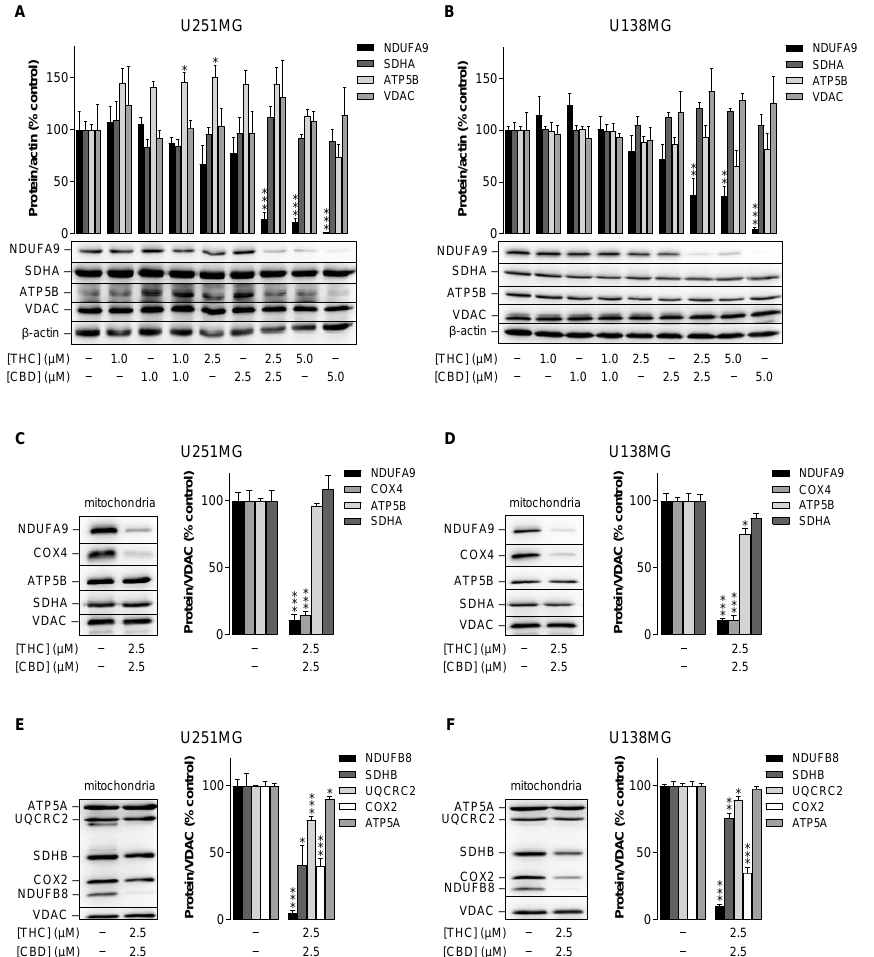
Figure 4. Influence of THC and CBD, administered alone or in combination, on protein levels of subunits of ETC complexes I (NDUFA9, NDUFB8), II (SDHA, SDHB), III (UQCRC2), IV (COX2, COX4) and V (ATP5A) in human glioblastoma cells. U251MG and U138MG cells were incubated with selected concentrations of THC and CBD or their combination (in a ratio of 1:1) for 24 h. Subsequently, cellular total protein extracts ( A , B ) or isolated mitochondrial fractions ( C – F ) were analysed for specific subunits of different ETC complexes by Western blots. All percentage values shown refer to the vehicle control, which was set to 100%. The values shown in the bar graphs are based on densitometric analyses of blots, whereby the specific subunits were normalised to β -actin ( A , B ) or VDAC ( C – F ). The blots shown are representative. The data in all panels are mean values ± SEM of n = 3–4 independent experiments per group. * p ≤ 0.05, ** p ≤ 0.01, *** p ≤ 0.001 vs. corresponding vehicle